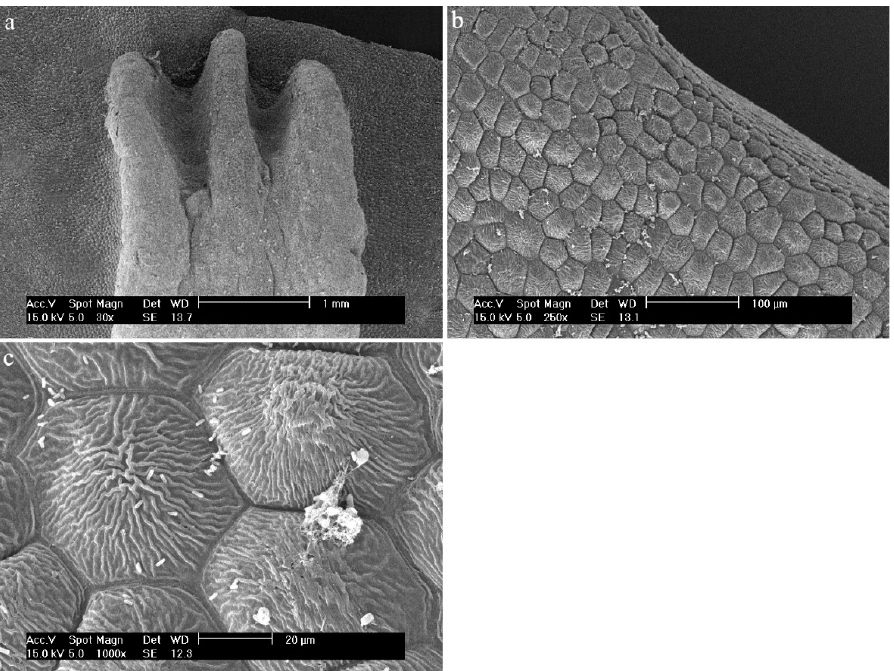
Figure 23. Dendrobium bifalce Lindl.: ( a ) the mesochile part of the labellum; ( b , c ) the epichile part of the labellum.